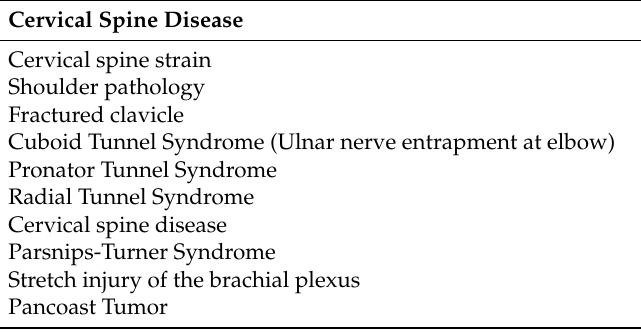
Table 5. Differential and associated